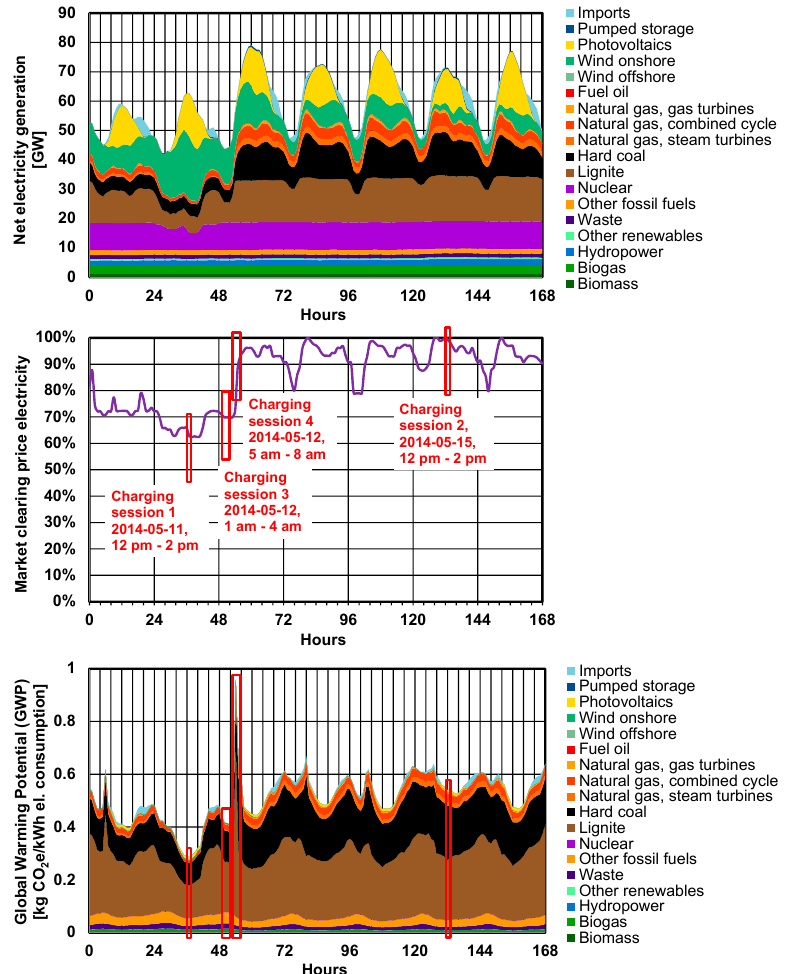
Figure 4. Hourly resolved net electricity generation, market clearing price and GWP in the week from 10 May 2014 to 16 May 2014.